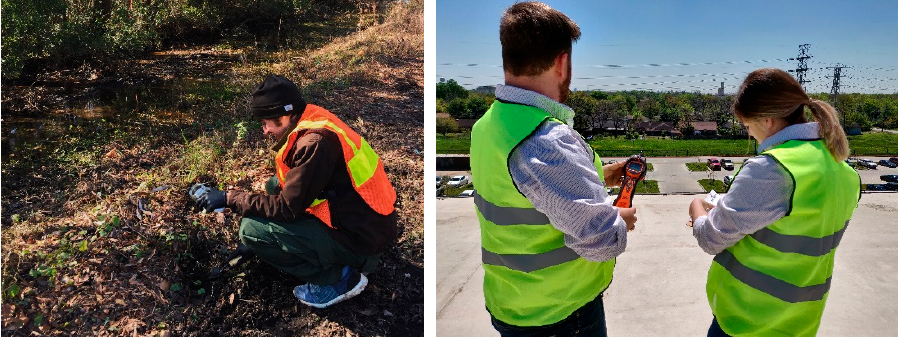
Figure 1. Water (left) and air (right) quality sampling in Manchester, TX. Figure 1. Water ( left ) and air ( right ) quality sampling in Manchester,